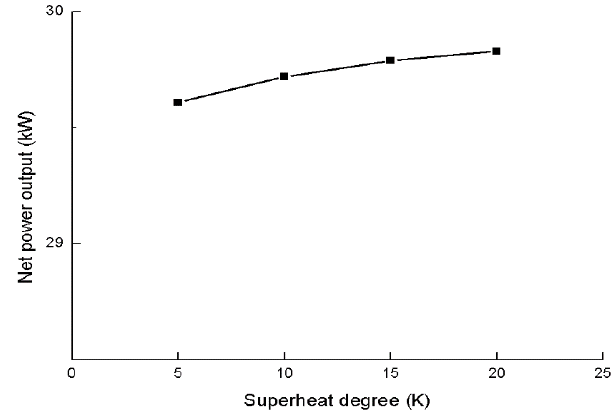
Figure 9. Influence of the superheat degree of the HT cycle working fluid on the net power output of DORC